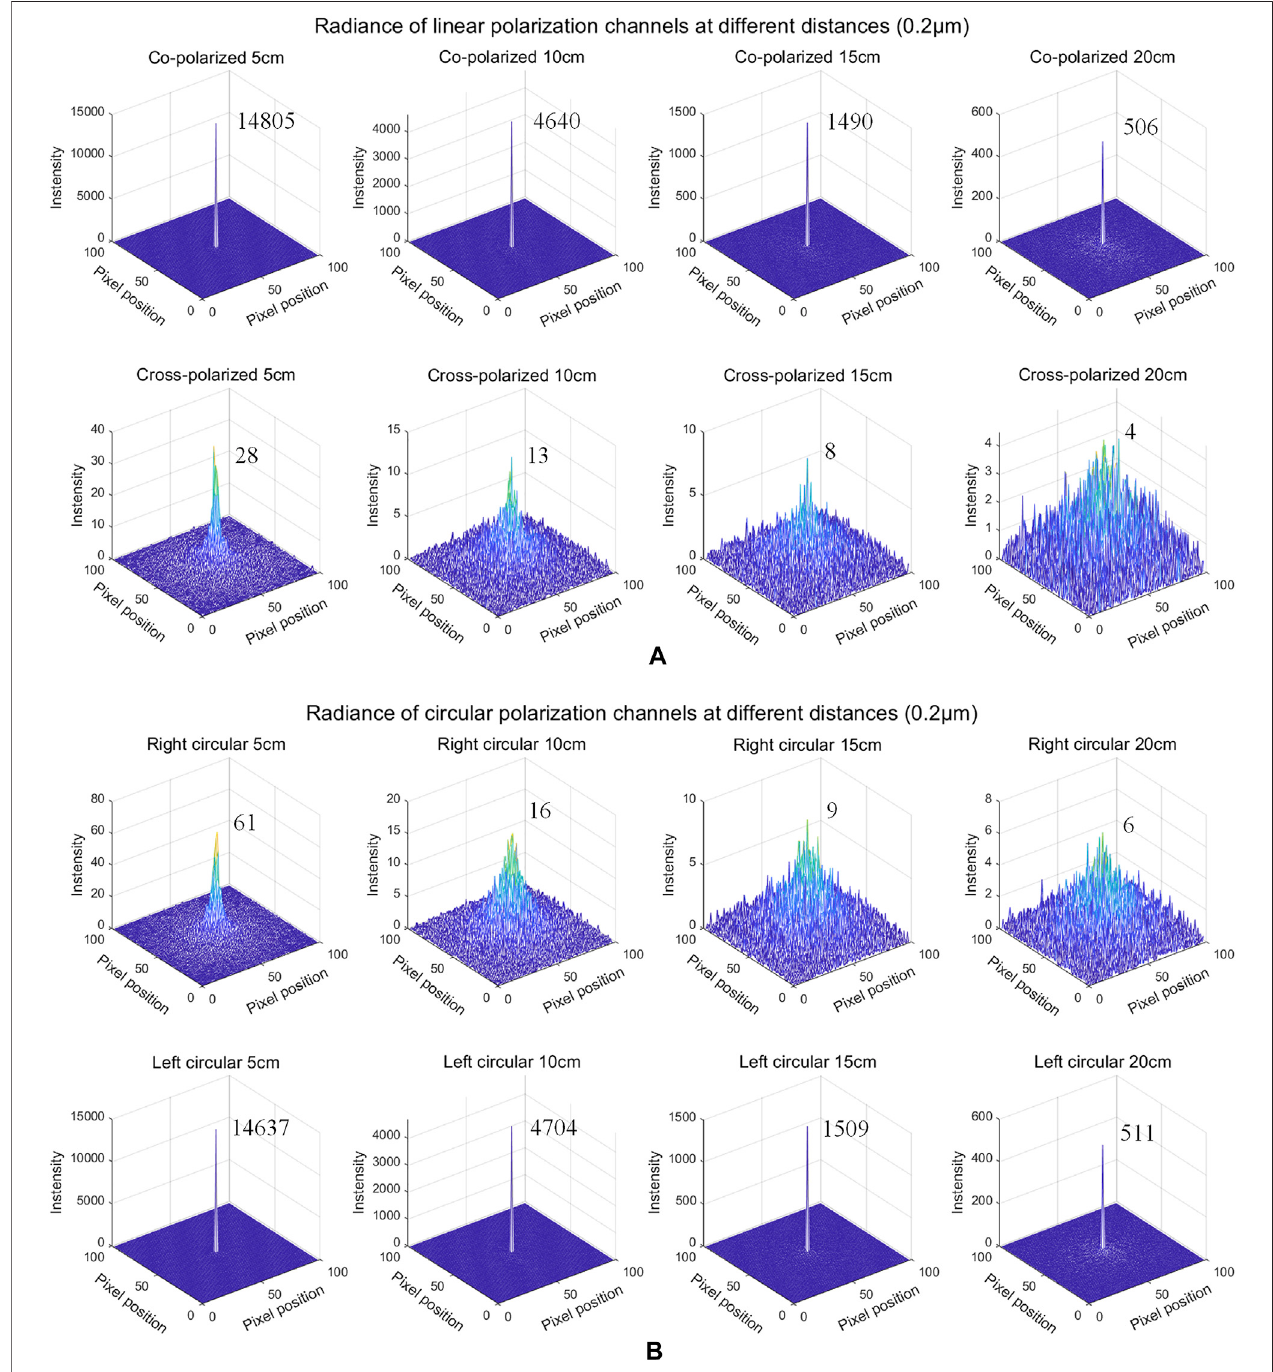
FIGURE 6 | Radiance of polarization channels at different distances in the medium with small-sized particles (0.2 μ m) (A) co-polarized and cross-polarized radiance, (B) right circular and left circular polarized radiance at 5 cm, 10 cm, 15 cm, 20 cm, respectively.